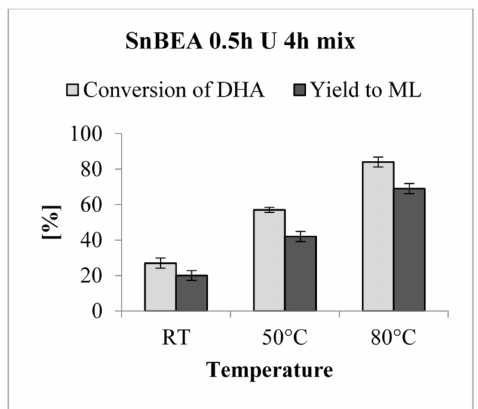
Figure 9. Reaction of DHA isomerization (DHA conversion and conversion yield to the desired reaction product—methyl lactate—ML) with the use of SnBEA 0.5 h U 4 h mix—application of conventional heating